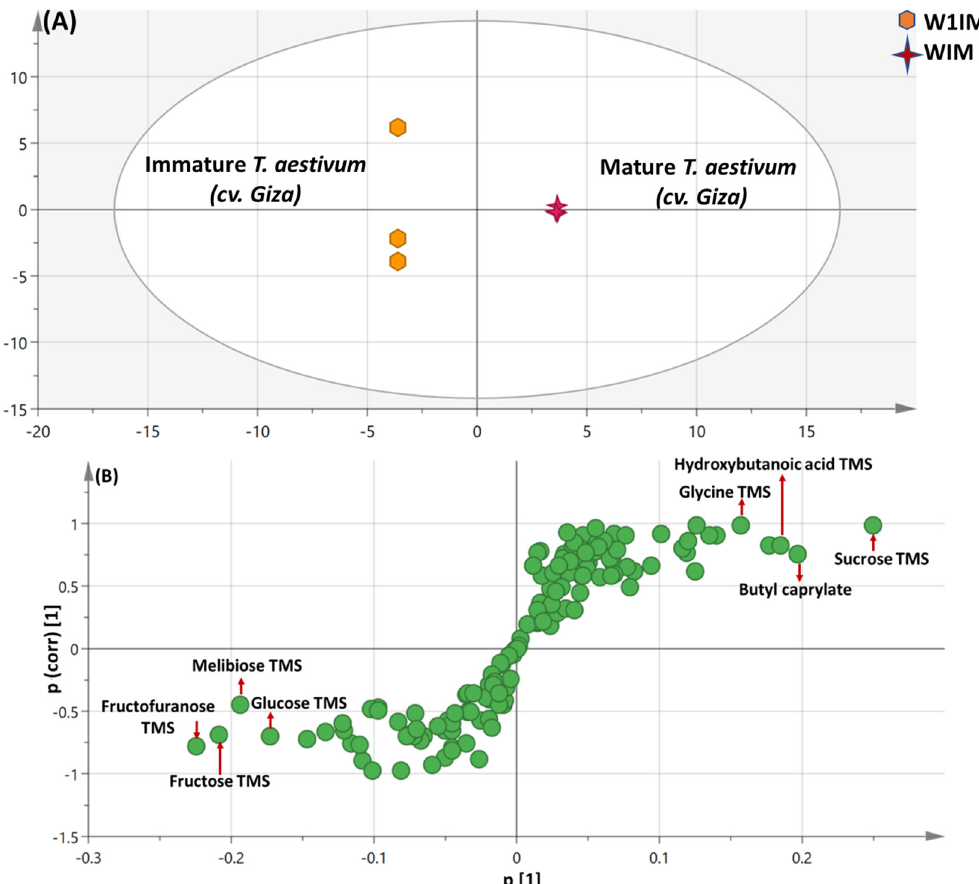
Figure 4. GC/MS dataset-based OPLS-DA score plot ( A ) derived from modeling silylated primary metabolites of mature vs. immature T. aestivum (cv. Giza) specimens ( n = 3). The respective loading S-plot ( B ) shows the covariance p[1] against the correlation p(corr)[1] of the variables of the discriminating component of the OPLS-DA model, with a p -value of 0.2. Designated variables are highlighted and identifications are discussed in the text.